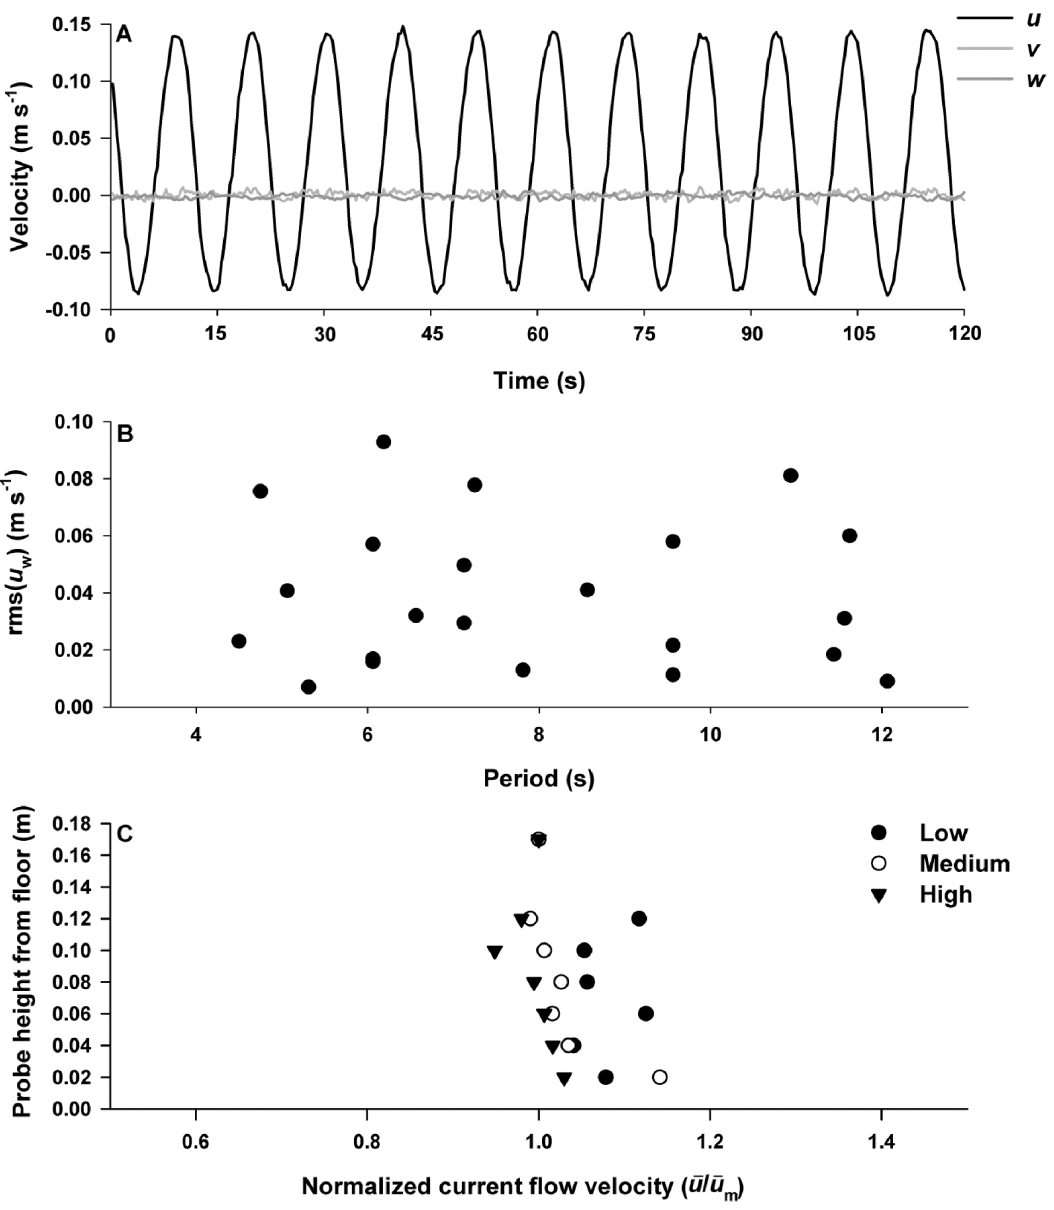
Figure 2. Hydrodynamic characterisation of the oscillatory water tunnel. (A) Sample wave form with underlying current ( u , v , and w velocities (m s 2 1 )) from an ADV positioned with the x probe oriented with the dominant current direction and the sample volume 0.04 m above the substrate (corresponding to the average height of the female sea urchins used in the trials). (B) Range of hydrodynamic conditions explored in the experimental trials, with both rms( u w ) (m s 2 1 ) and period (s) manipulated independently. (C) Test section velocity profiles in the absence of the female sea urchin. Mean longitudinal velocity ( u¯ ) normalized by mean longitudinal velocity of the maximum probe height ( u¯ m ) from the tank floor (0.18 m) from three velocity profiles representative from each of the rms( u w ) categories: LOW [ , 0.03 m s 2 1 ], MEDIUM [ . 0.03 , 0.06 m s 2 1 ], HIGH [ . 0.06 m s 2 1 ]